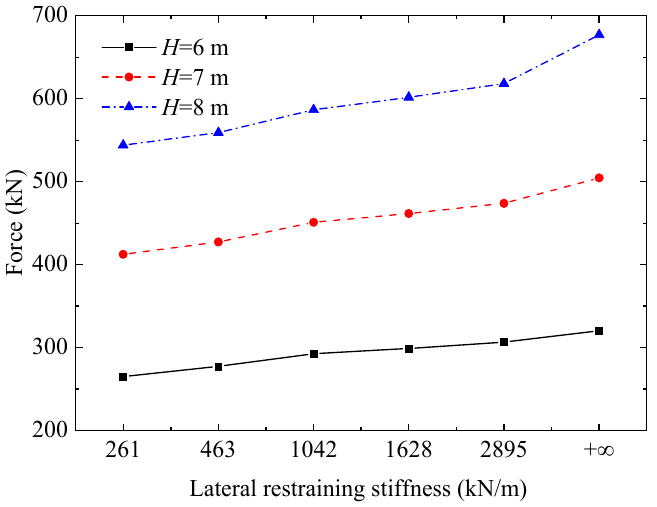
Figure 19. Influence of the lateral restraining stiffnesses on the vertical force for Case E23/Cs (1).